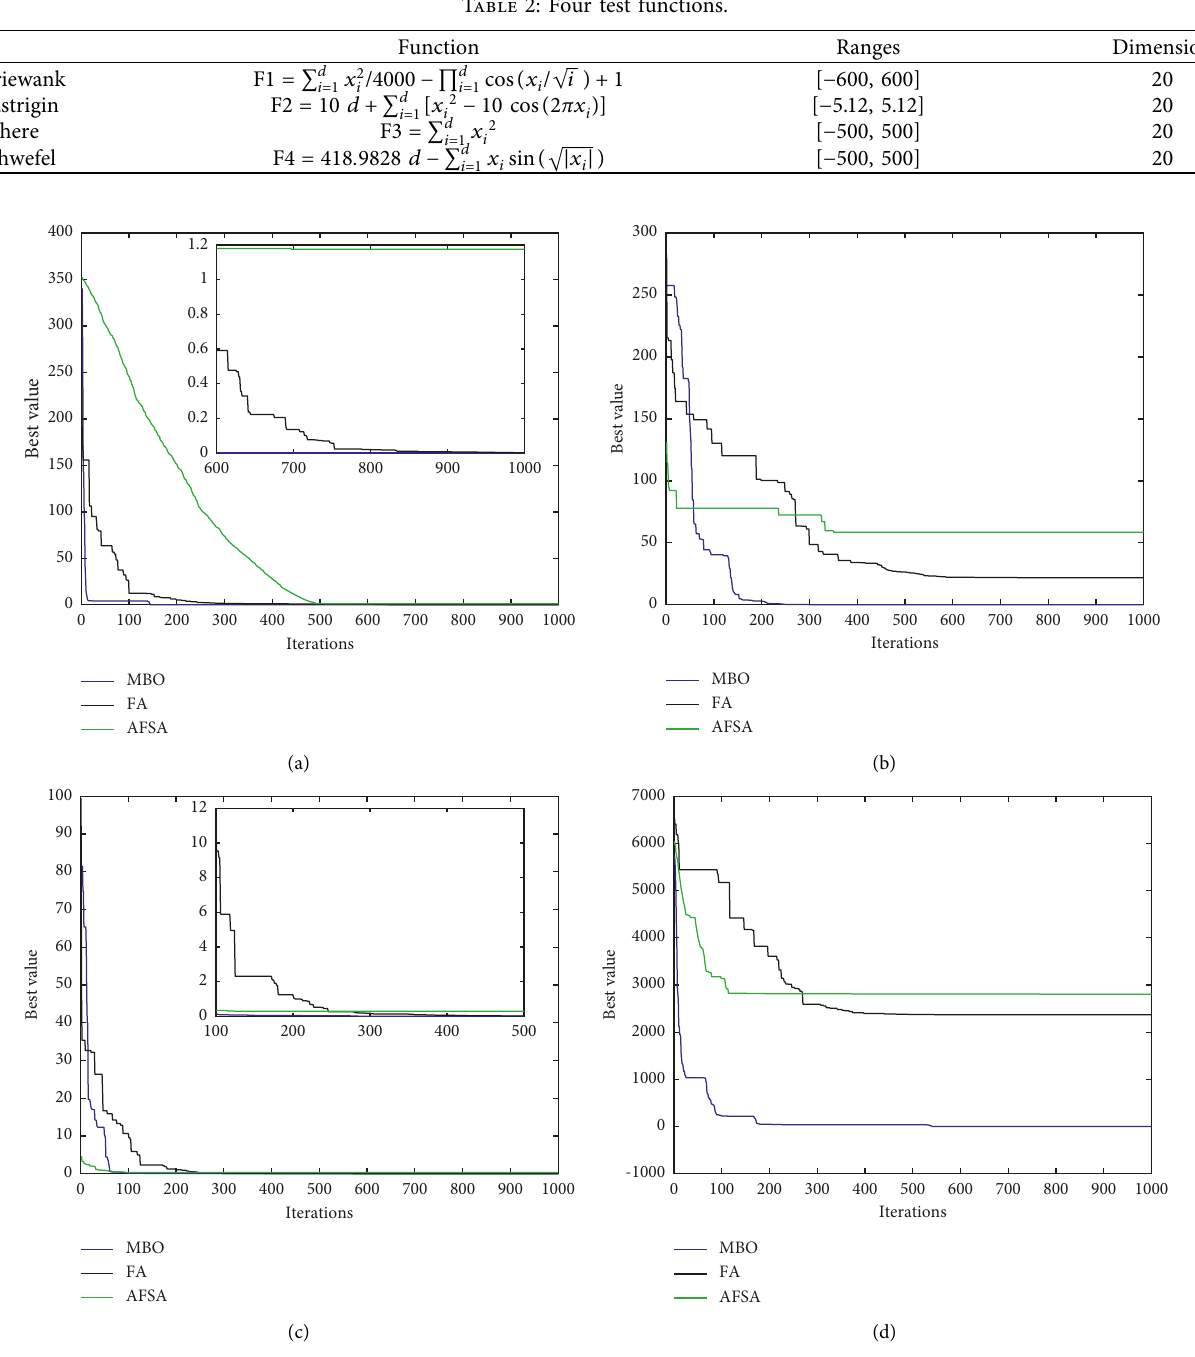
Figure 4: The convergence performance of different algorithms on F